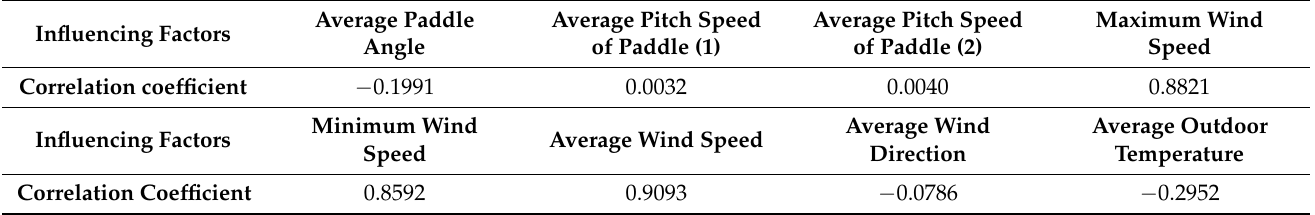
Figure 4. PV power and impact factor data curves in one day. Table 1. SCC results between the wind power and other influencing factors.